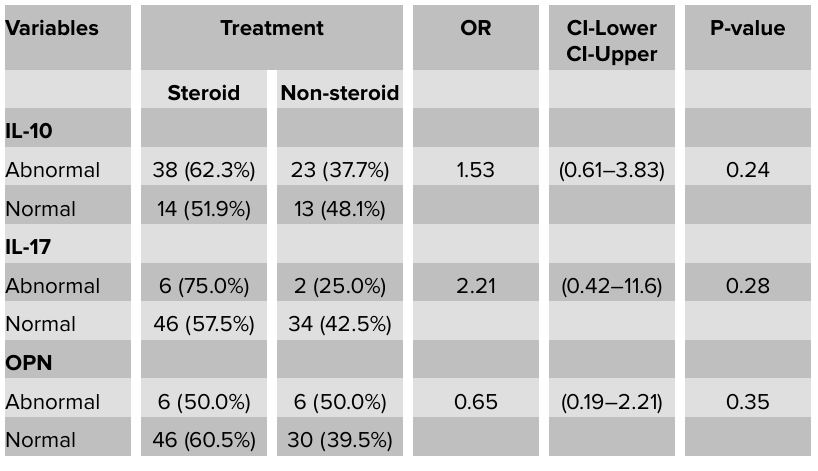
TABLE 4: Association between interleukins IL10, IL17, OPN and types of